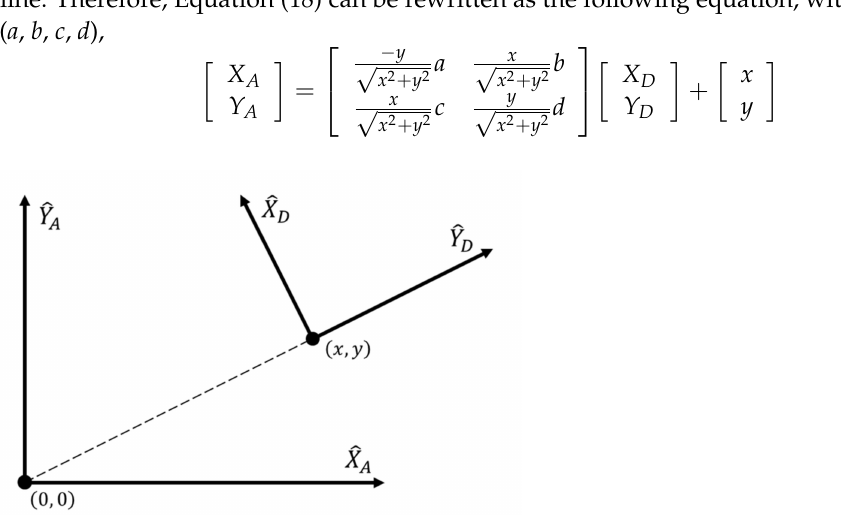
Figure 8. Relationship between the coordinate systems { A } and { D